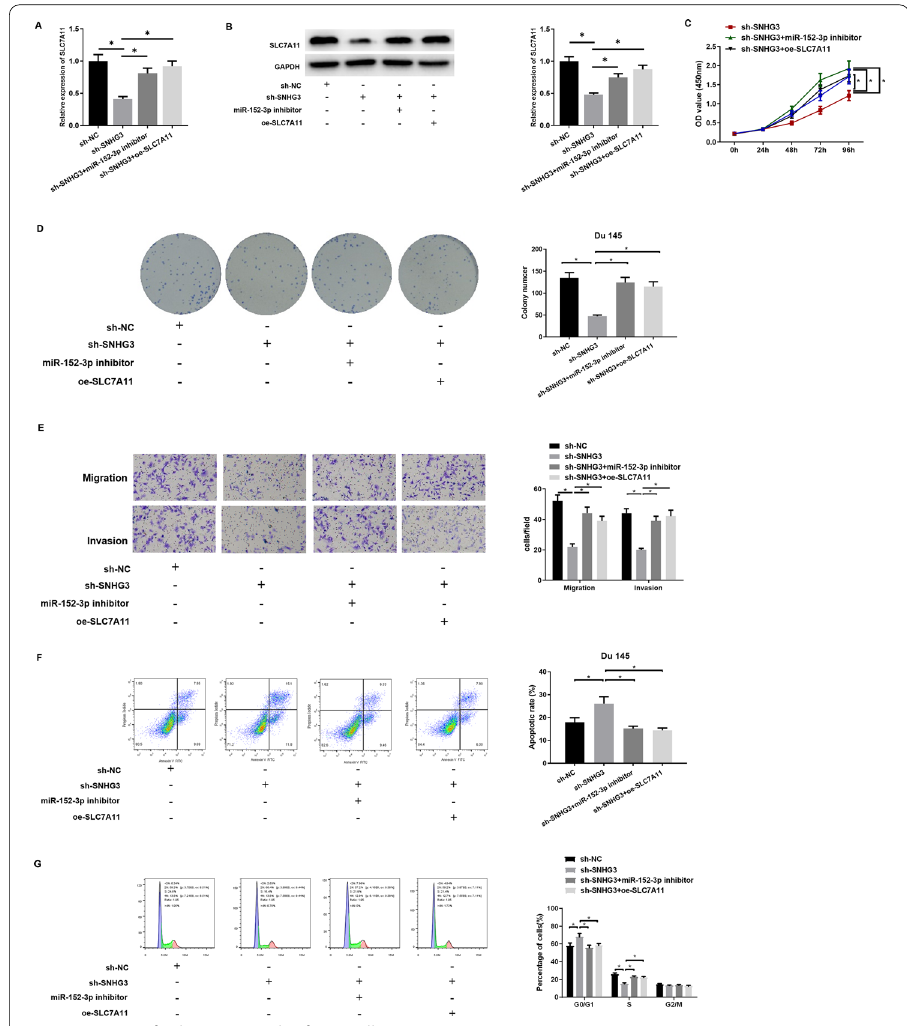
Fig. 5 SNHG3 facilitates growth of PCa cells via miR-152-3p/SLC7A11 axis. A SCL7A11 mRNA expression in cells of each transfection group (sh-NC, sh-SNHG3, sh-SNHG3 sh-SNHG3 oe-SLC7A11), * p < 0.05; B protein expression of SLC7A11 in cells of each transfection group, + * p < 0.05; C CCK-8 assayed proliferative ability of Du 145 cells, * p < 0.05; D colony formation assay detected colony formation of Du 145 cells, * p < 0.05; E transwell measured migration and invasion of Du 145 cells, * p < 0.05; F , G flow cytometry assessed apoptosis and cell cycle progress of Du 145 cells. All the above experiments were repeated 3 times, * p <